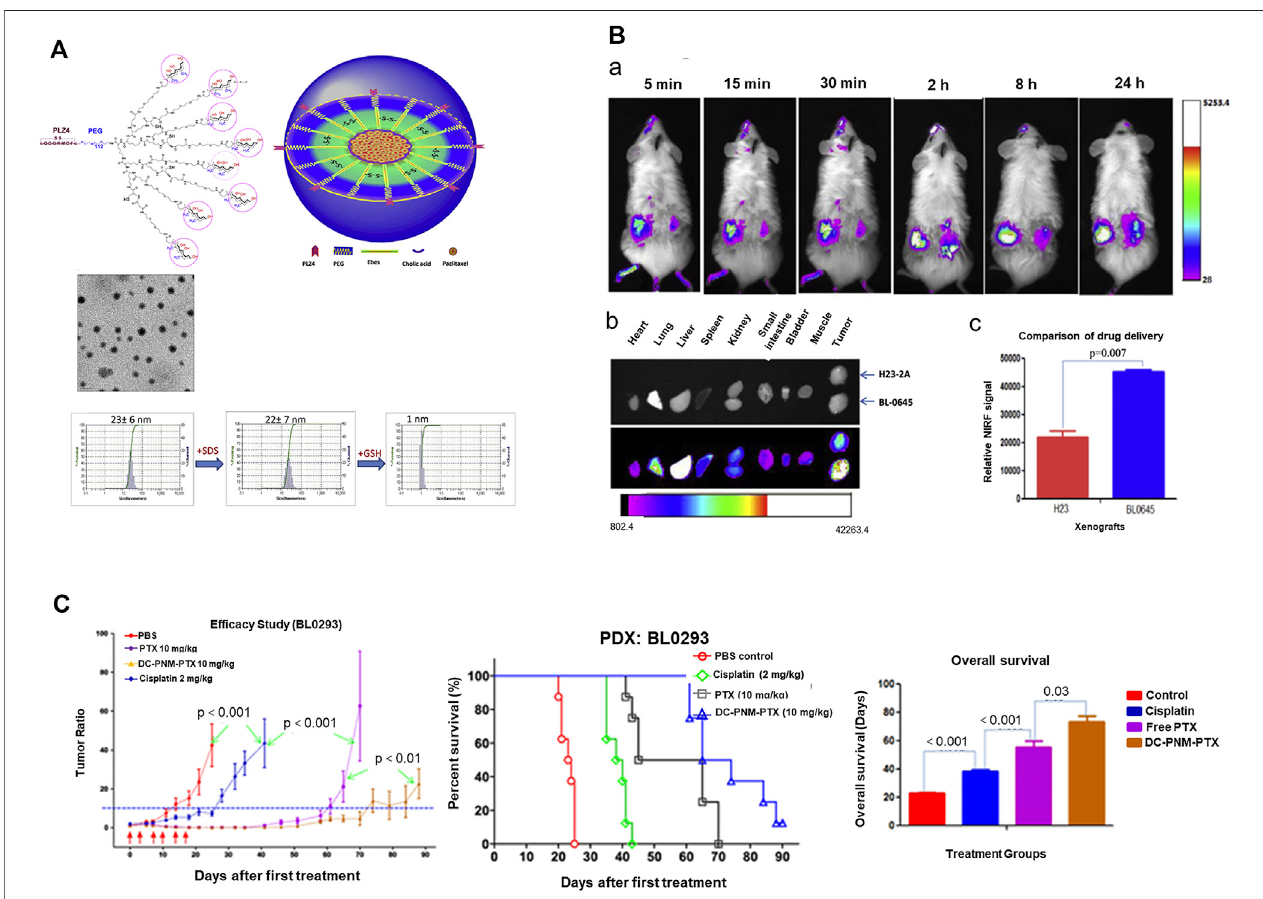
FIGURE 7 | Reducing responsive nanogel for targeted drug delivery and enhancement of the drug curative effect. (A) Schematic diagram and characterization of PLZ4-telodendrimer and DC-PNM. (B) Delivery of DC-PNM and distribution of drugs in various organs in vivo. Reproduced with permission from (Pan et al.,